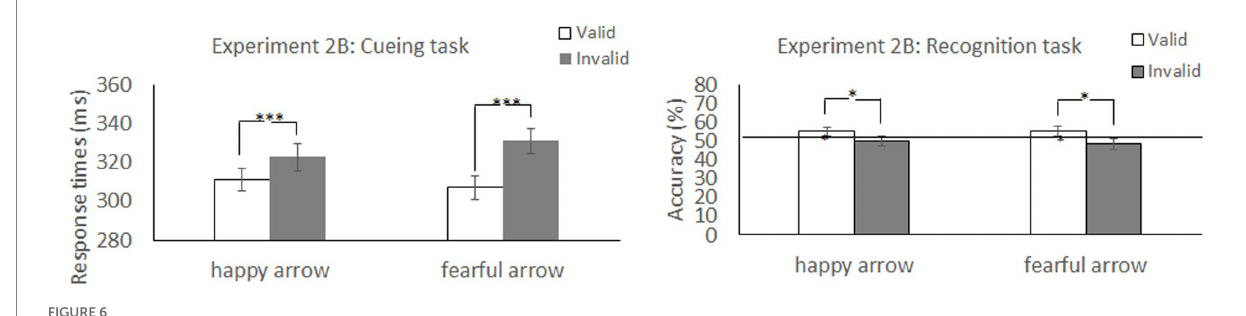
FIGURE 6 Mean difference in response times in the cueing task and accuracy in the recognition task to happy face-associated and fearful face-associated arrow cues. *** p < 0.001; * p <